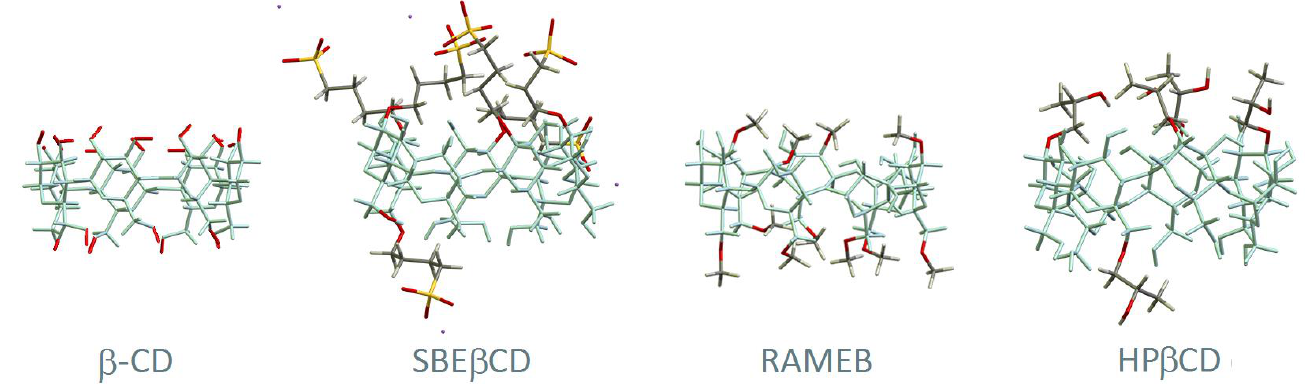
Figure 1. Schematic depiction of the structure of β -CD and its derivatives of pharmaceutical use. The hydroxyl groups located at the rims of β -CD, highlighted in red, serve as anchoring sites for chemical functionalisation. In the derivatives, only the functional groups (hydroxypropyl, sulphobutylether and methoxyl) are highlighted with colour. Adapted from Braga et al. [9] under a Creative Commons licence (CC BY 4.0).